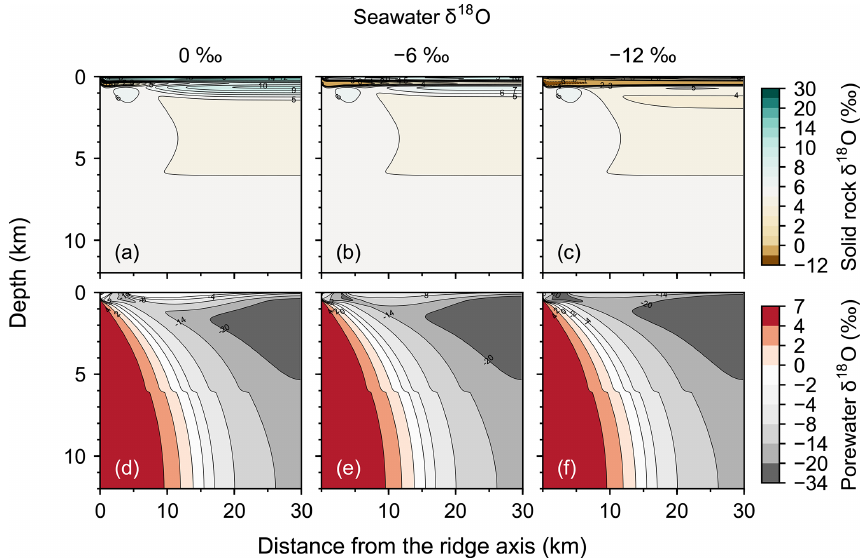
Figure 2. Two-dimensional distributions of solid rock and porewater δ 18 O ( a–c and d–f , respectively) at seawater δ 18 O values of 0‰, − 6‰ and − 12‰ ( a and d , b and e , and c and f , respectively).